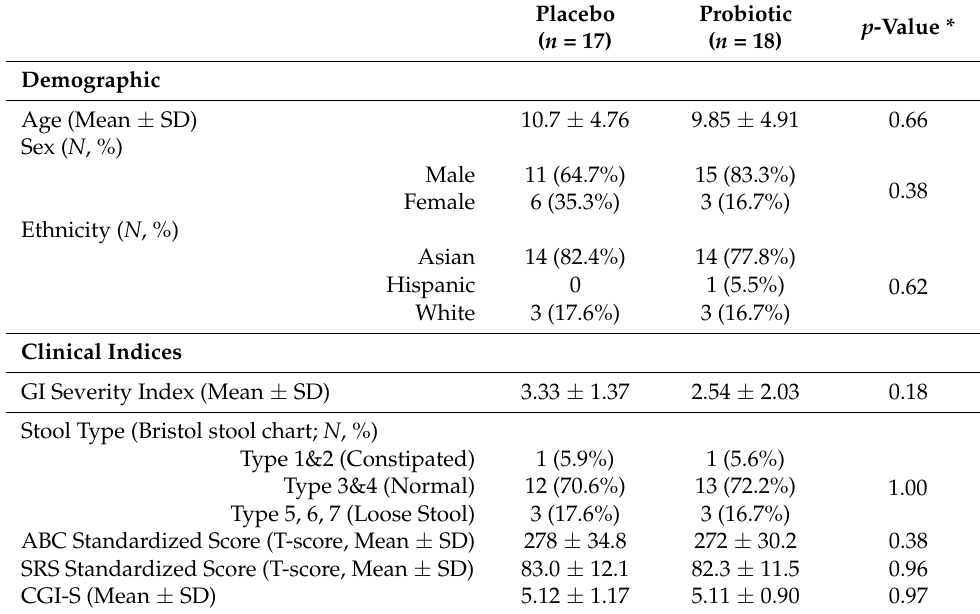
Table 1. Summary of subject demographics and clinical indices at baseline.